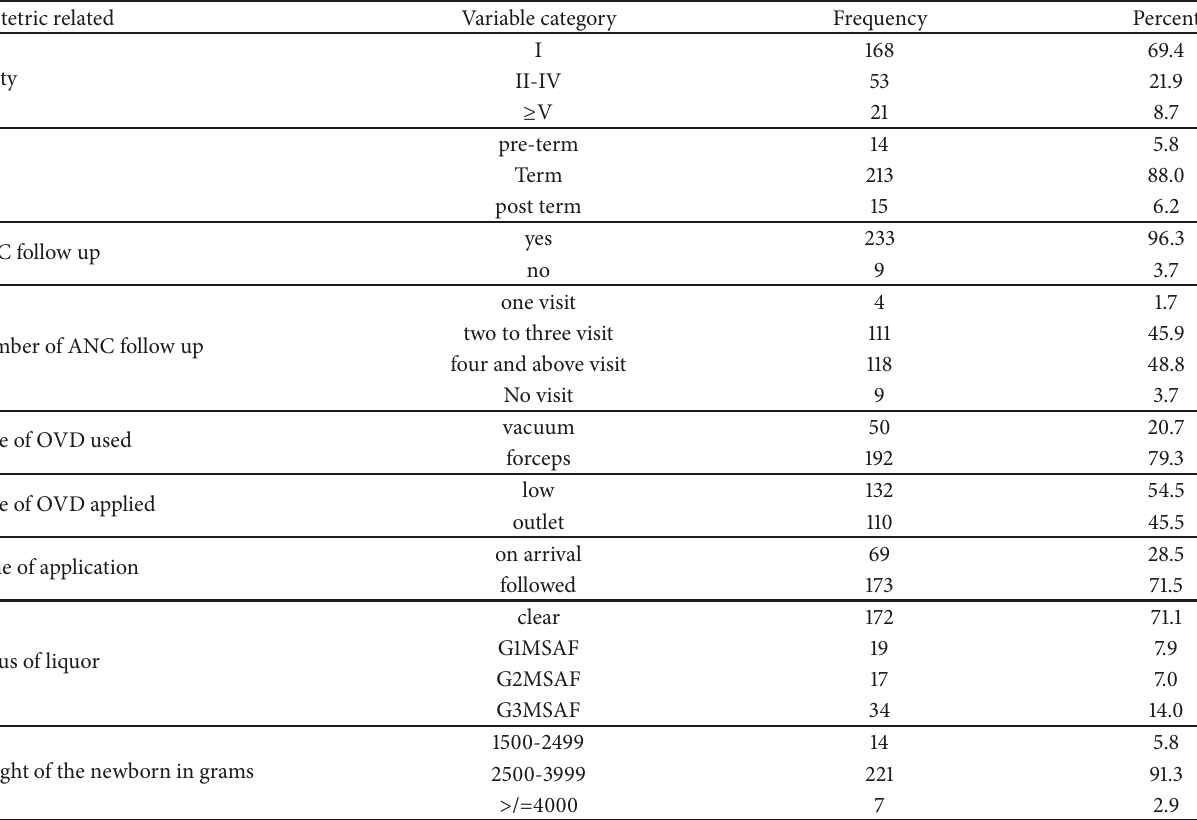
Table 2: Frequency distribution of obstetric related variables among mothers who gave birth by OVD in JUMC December 1, 2016–May 30, 2017.